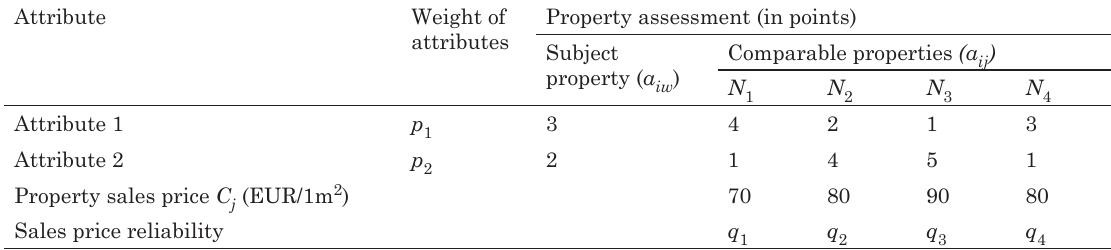
Table 1. the basis for comparable properties and their assessment attribute Weight of Property assessment (in points) attributes